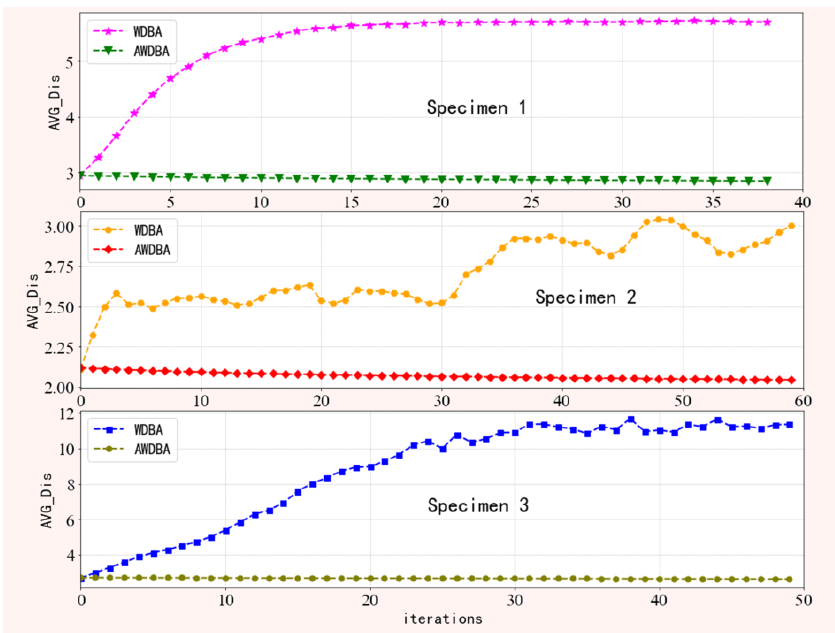
Figure 3. A comparison of the average distance of new data synthesized by WDBA and AWDBA.